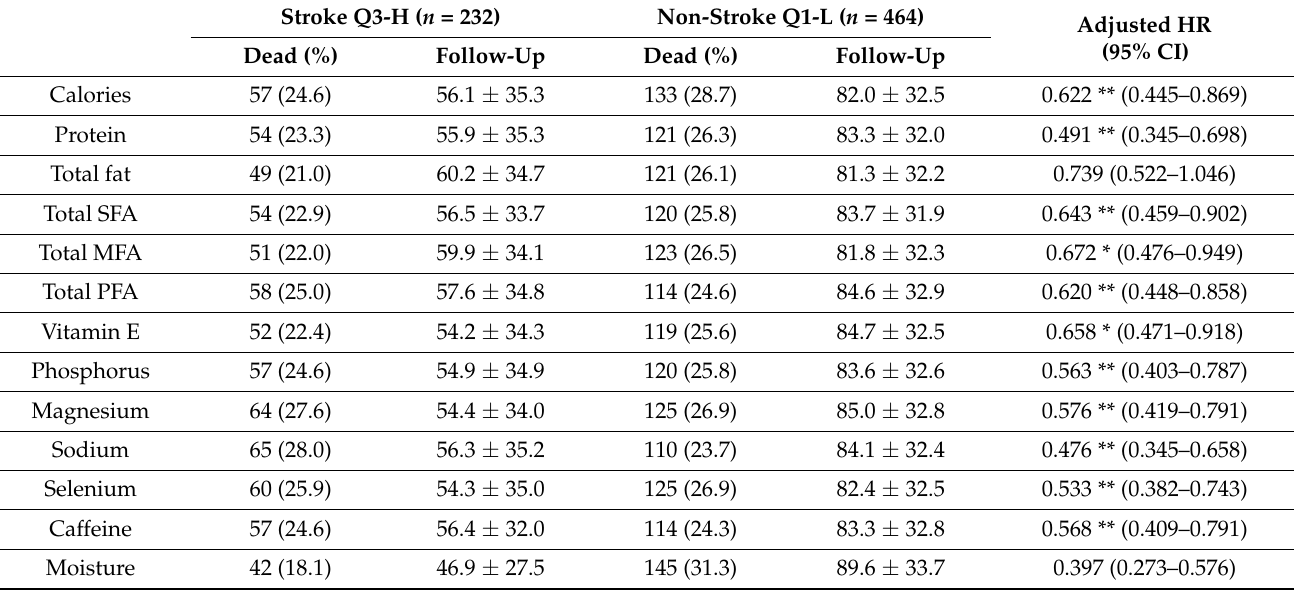
Table 5. Impact of dietary consumption on survival in patients with and without